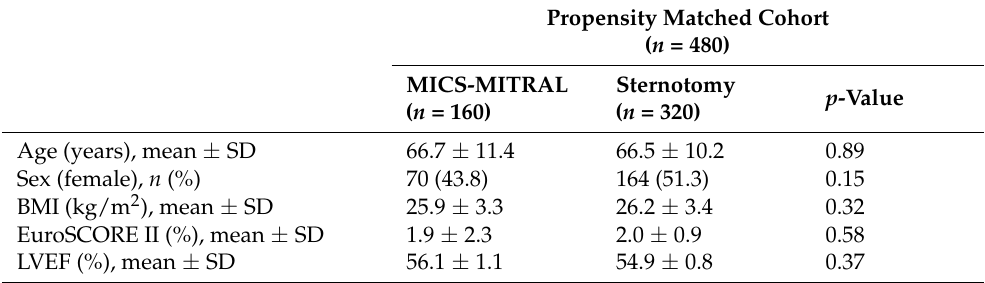
Table 1. Univariate analysis of balanced matching parameters after 1:2 propensity score